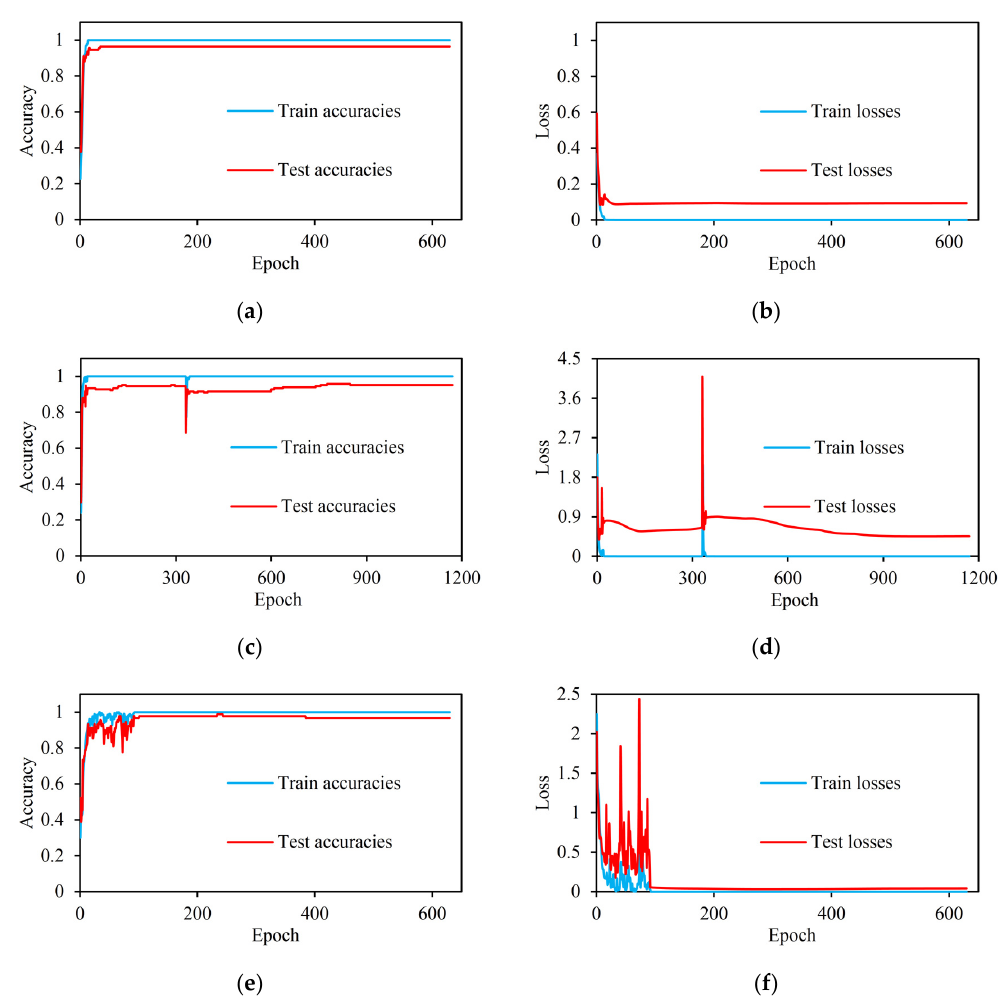
Figure 9. Curves for the accuracies and losses of the training and testing sets. ( a ) The accuracies of the ASL dataset with 360 samples; ( b ) The losses of the ASL dataset with 360 samples; ( c ) The accuracies of the ASL dataset with 480 samples; ( d ) The losses of the ASL dataset with 480 samples; ( e ) The accuracies of the Handicraft-Gesture dataset with 300 samples; ( f ) The losses of Handicraft-Gesture dataset with 300